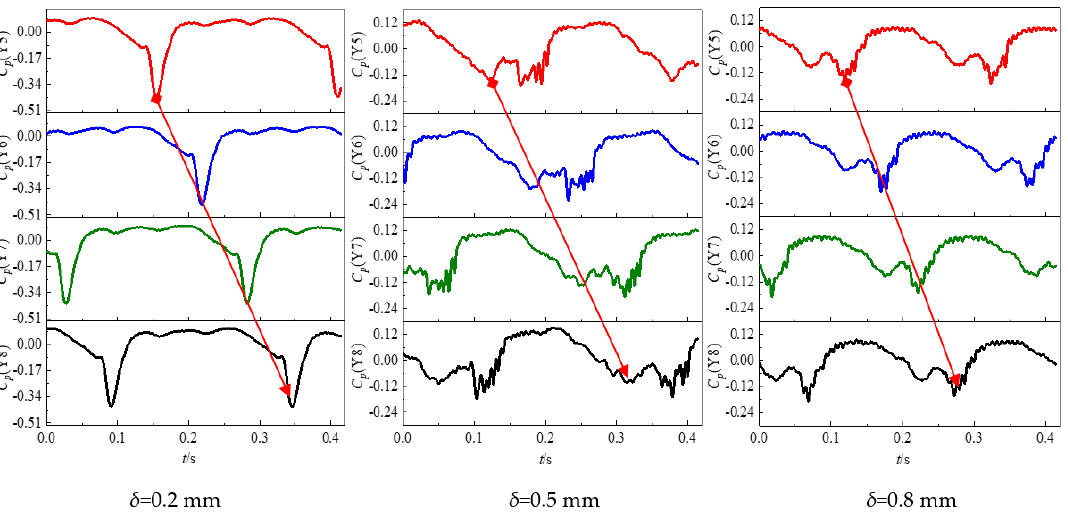
Figure 21. Time domain diagram of pressure fluctuation at impeller outlet monitoring point (Y5, Y6, Y7, Y8). Y7,